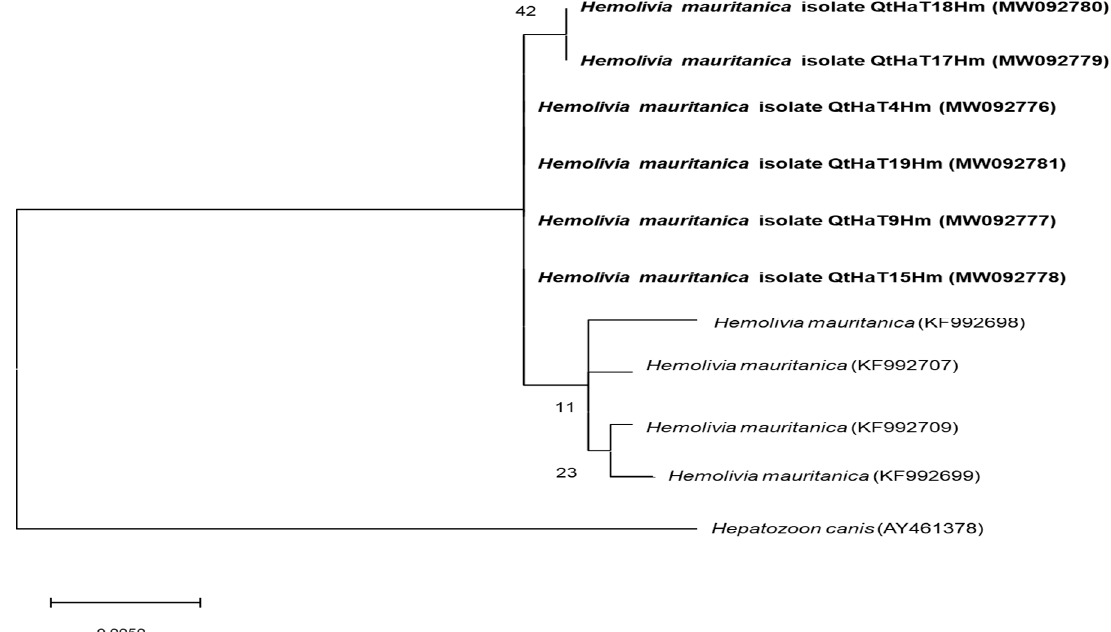
Figure 3. Molecular Hemolivia mauritanica identification according to phylogenetic analysis using the maximum likelihood method and Hasegawa-Kishino-Yano model with the 18S rRNA gene. The analyzed sequences are in bold. The accession numbers for nucleotide sequences from GenBank are presented with species names. The branch numbers mean bootstrap support (1000 replicates). The tree is drawn to scale, with branch lengths measured in the number of substitutions per site.